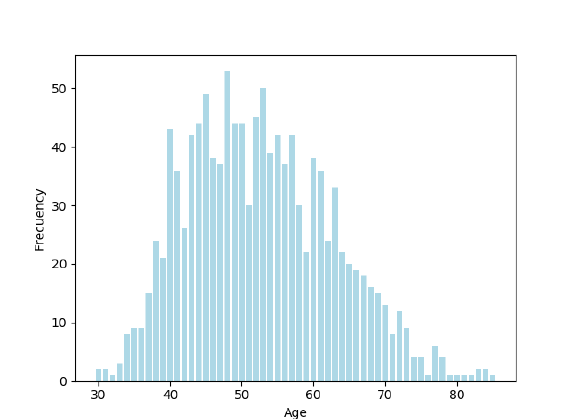
Figure 2. Age distribution.